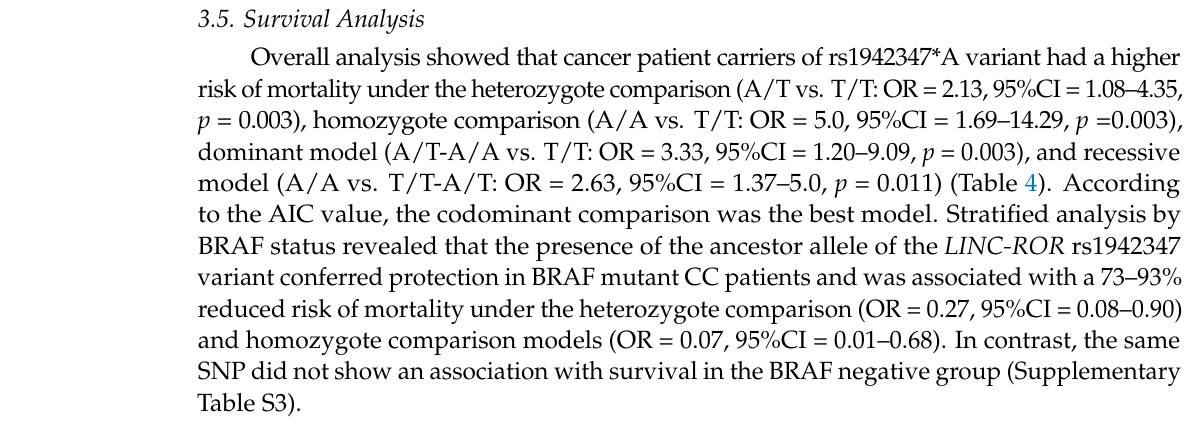
Table 4. Genetic inheritance association models for the LINC-ROR gene variant and mortality